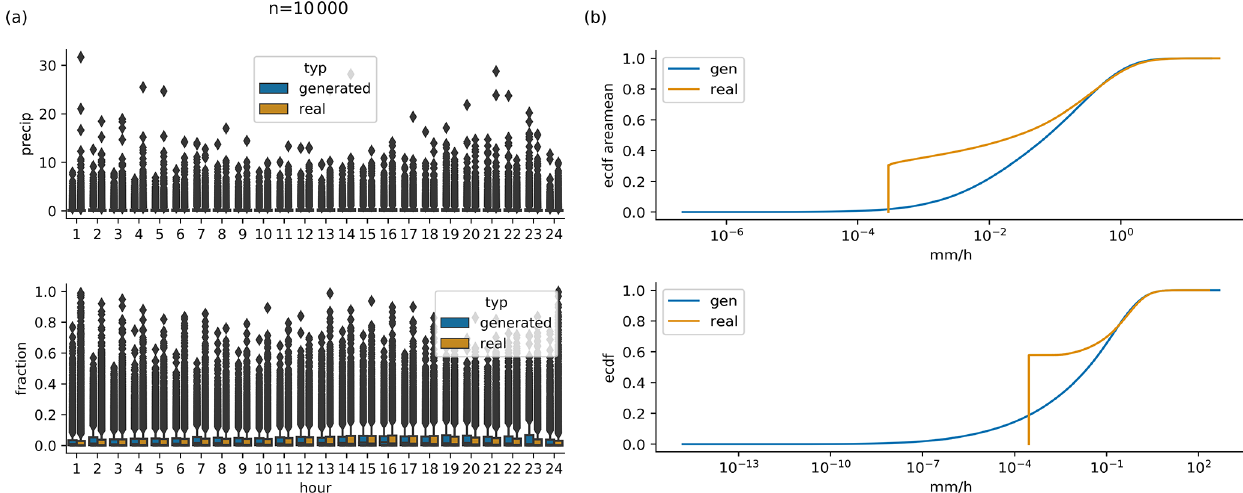
Figure C1. (a) Daily cycle of 10000 randomly selected real observations and scenarios generated by conditioning on exactly the same 10000 daily sums. Same as Fig. 7a but with outliers shown. (b) Cumulative distribution functions of generated and observed hourly area mean precipitation (upper panel) and hourly point-level precipitation (lower panel); same data as in (a) . Same as Fig. 7b, but with the full range on the x axis.